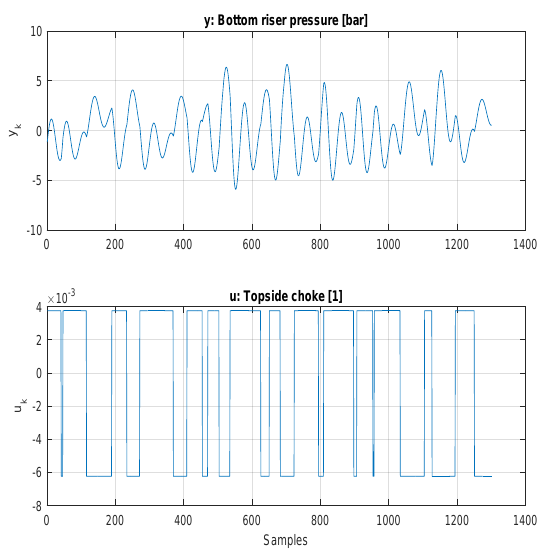
Figure 4: The identified models simulated and com- pared to validation data gathered from the real process (Di Meglio). We have the follow- ing validation performances (measured with MSE); V = 0 . 1912, V PEM = 0 . 2175 and DSR 9 3 V LIN = 0 . 2182.